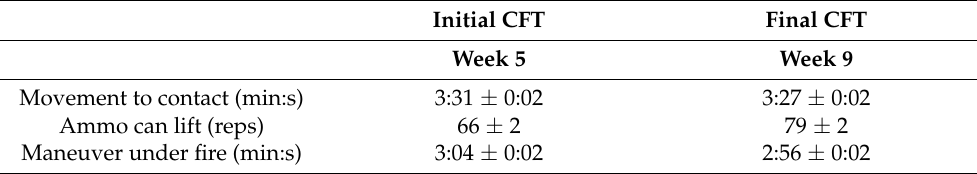
Table 3. Combat fitness test raw